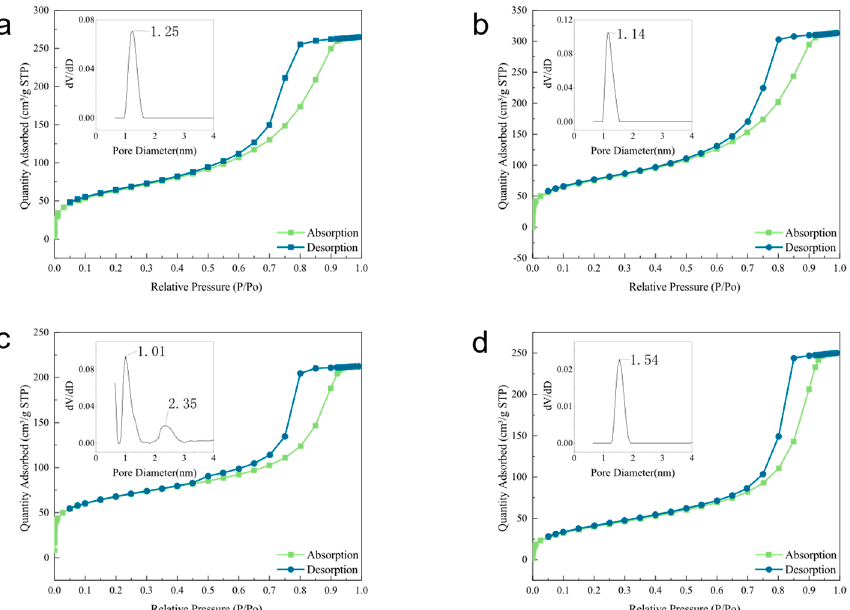
Figure 2. N 2 adsorption isotherms and pore size distributions of MIL − 101 − Ppa@SiO 2 ( a ), MIL − 101@SiO 2 ( b ), NH 2 − MIL − 101@SiO 2 ( c ) and NH 2 − MIL − 101 − Ppa@SiO 2 ( d ).